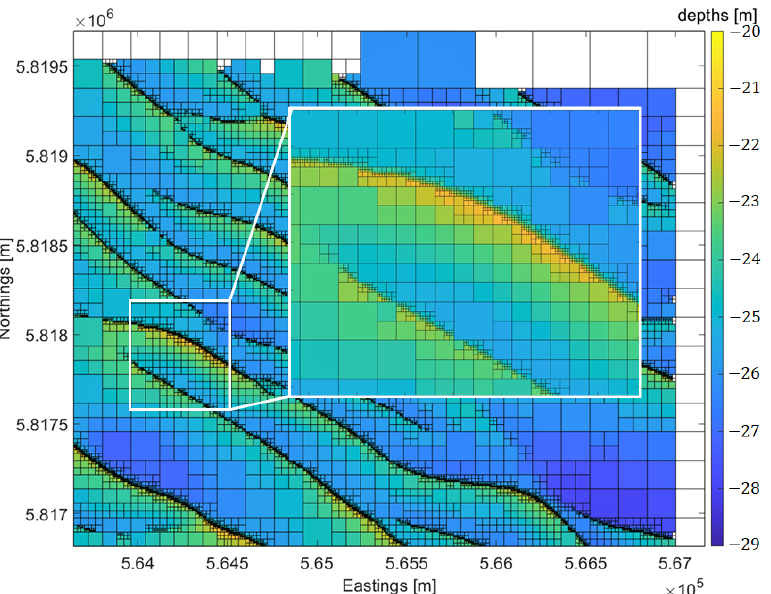
Figure 2. Example of a single epoch quadtree decomposition for creating a multi-resolution DEM. Inset image shows a subset area of larger depth variability (sandwave features) where a minimum grid cell size of 5 m is obtained near the crest of the